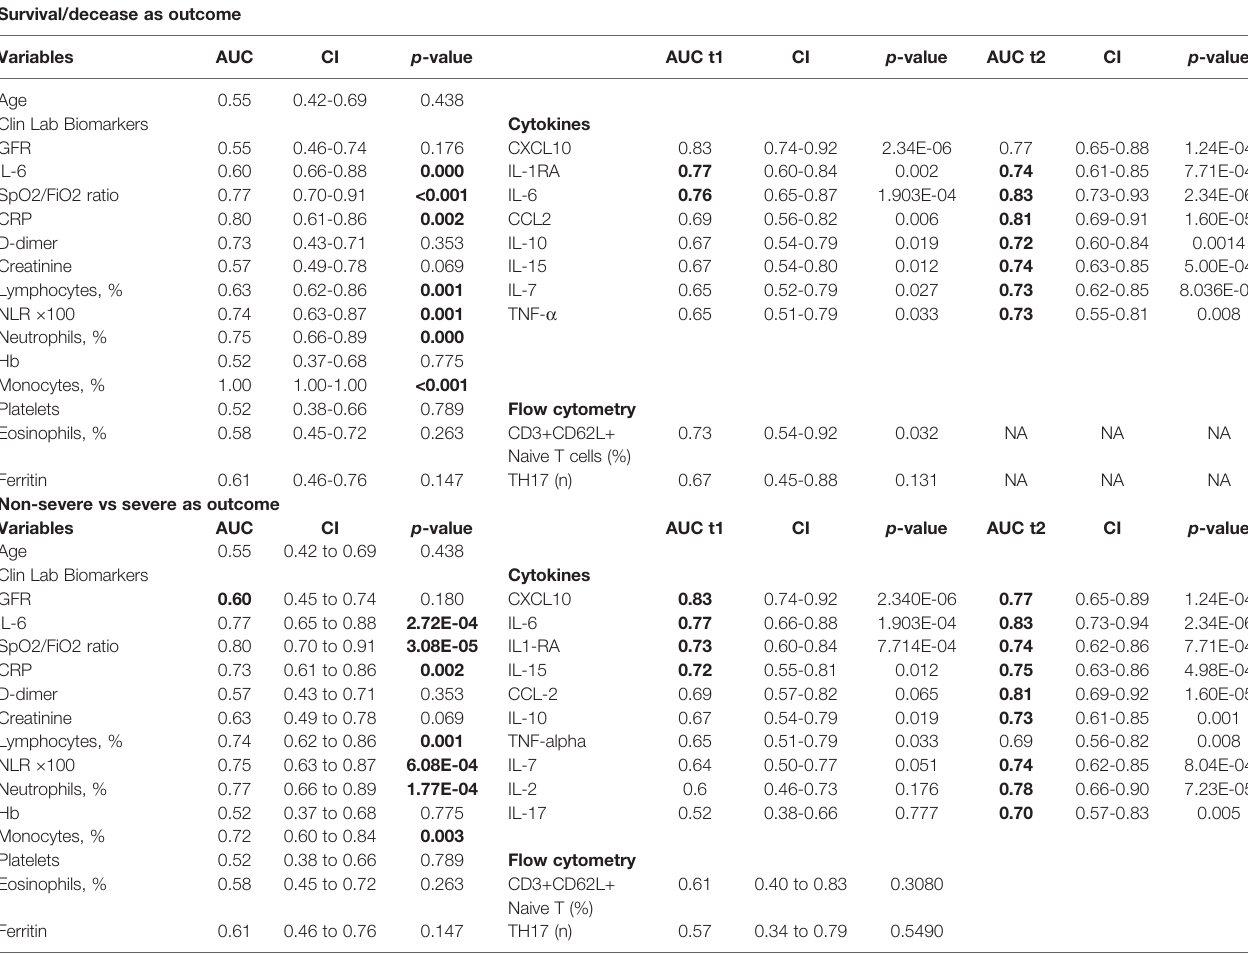
TABLE 7 | Performance of expanded immunological parameters in the special immunological studies group as assessed by ROC curve analysis and compared with other variables in the same group. Survival/decease as